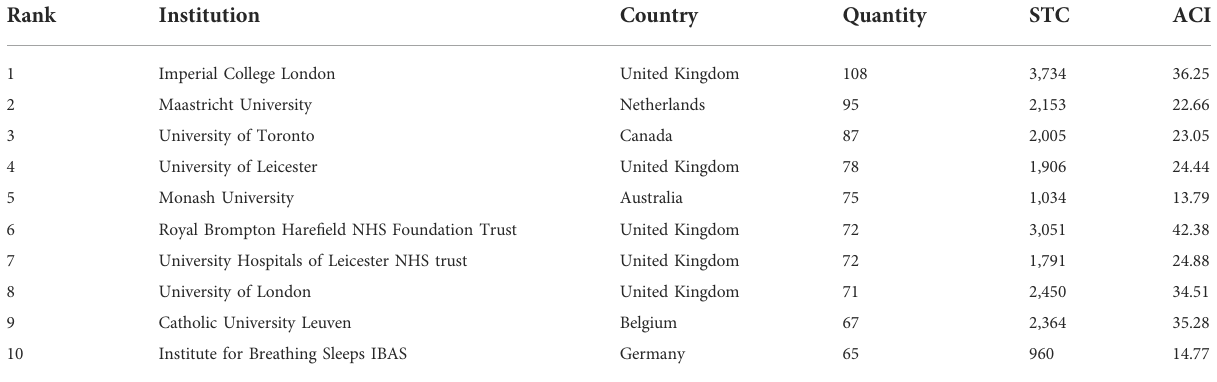
TABLE 3 Top 10 institutions in the studies of COPD and exercise therapy. Rank